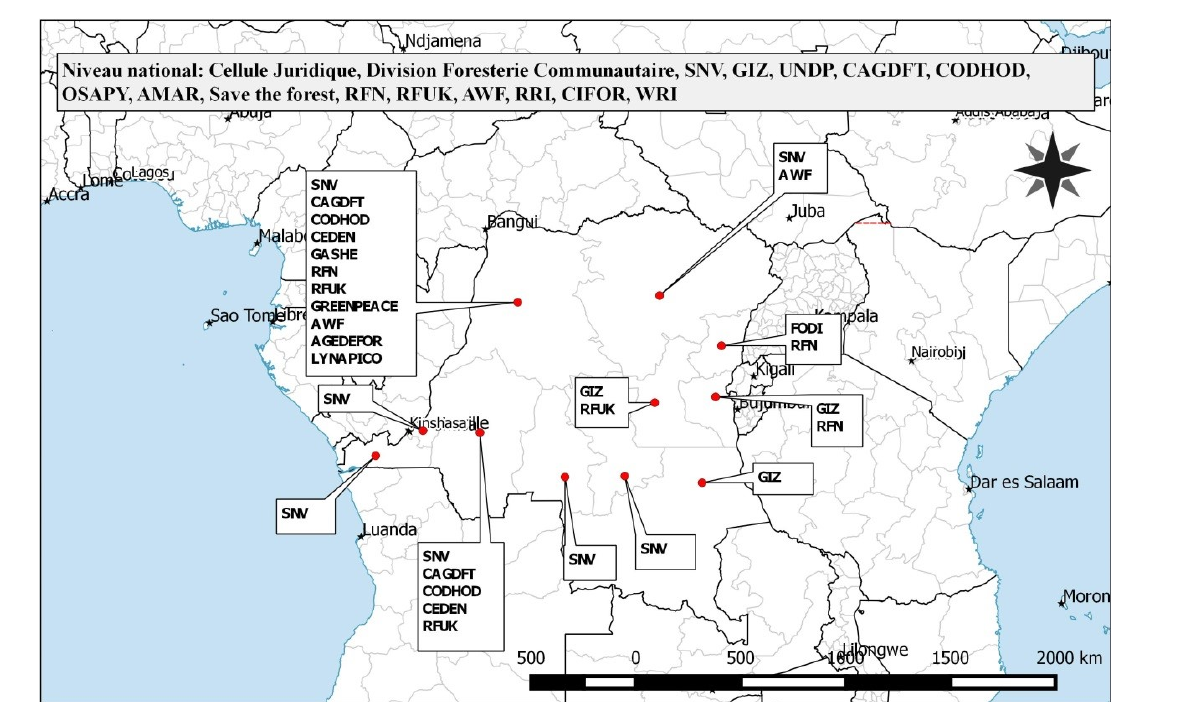
Fig. 1 . Pilot experiments in community forestry in the Democratic Republic of